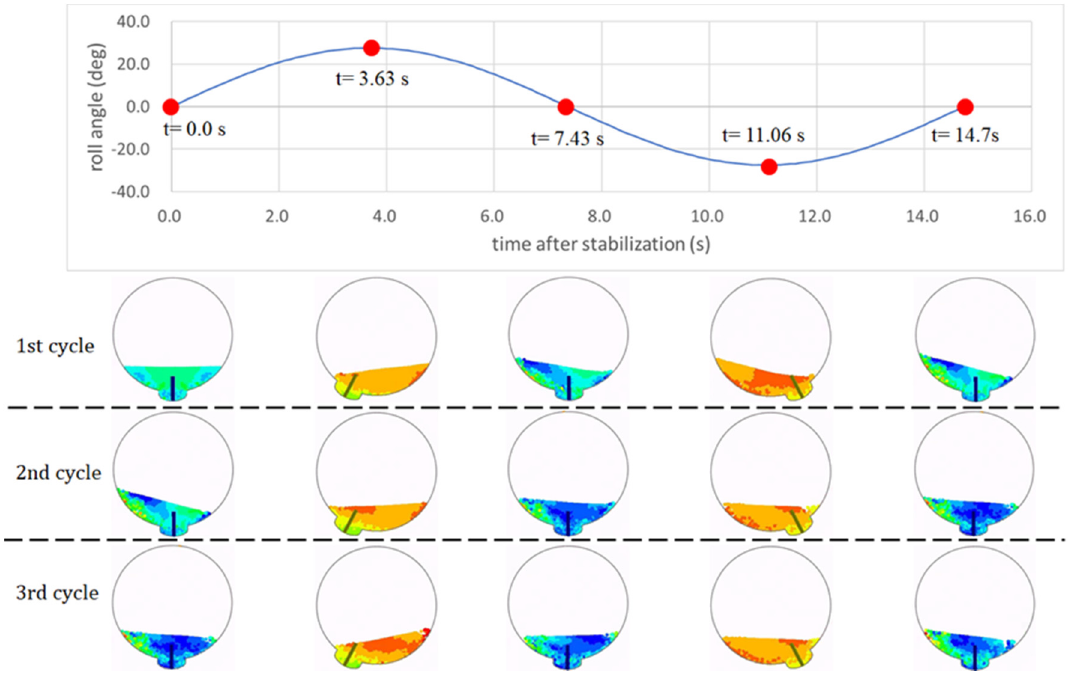
Figure 8. Flow snaps in each cycle of Model 3 under rolling condition.